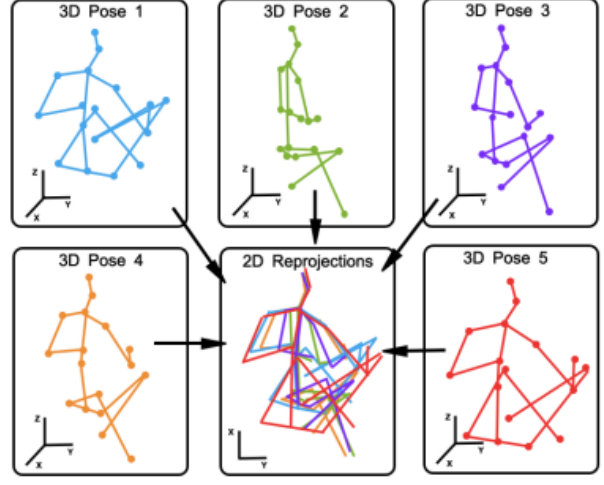
Figure 1. Illustration of depth ambiguity of 3D